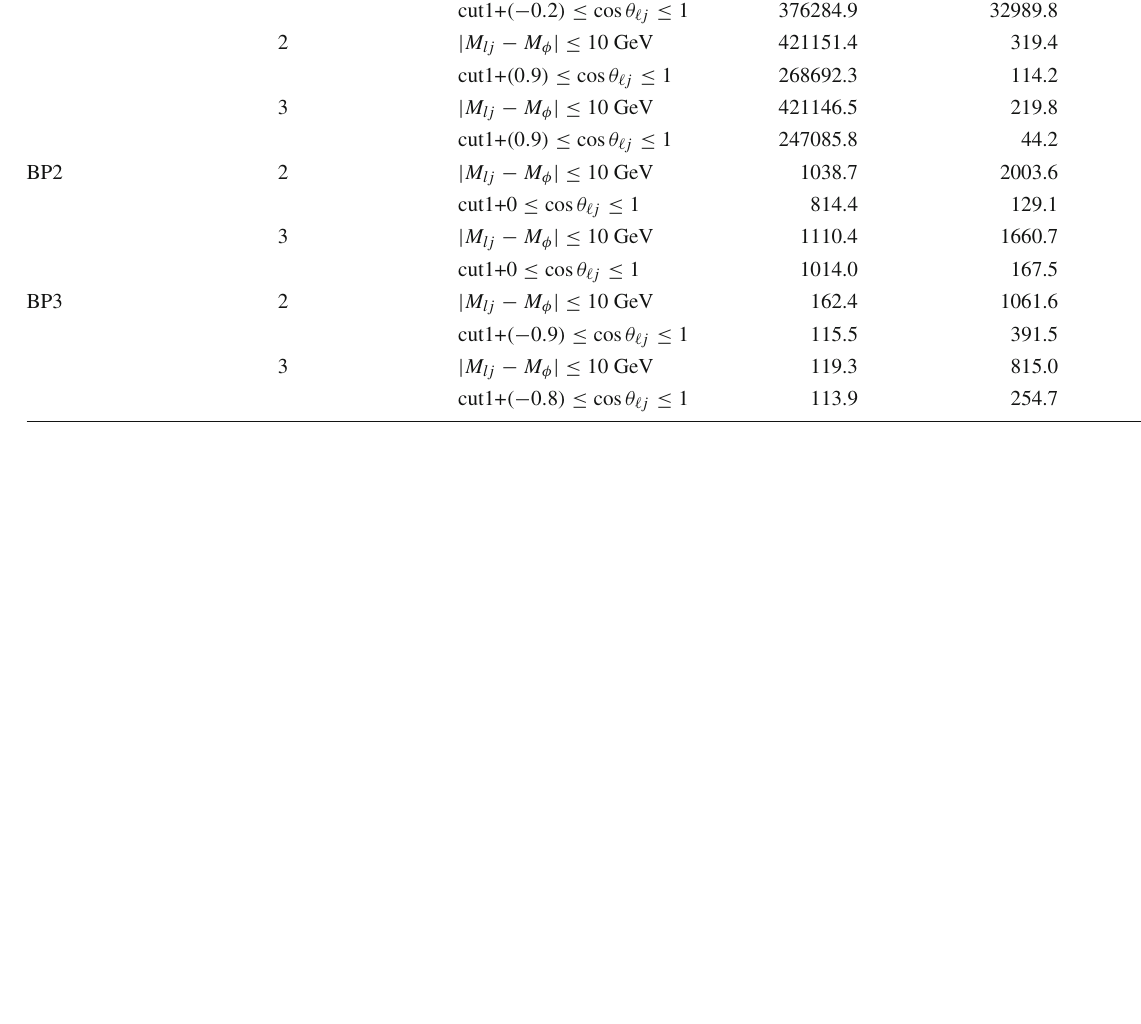
Table 13 Signal-background analysis for leptoquark ( U + 5 Bench-mark points